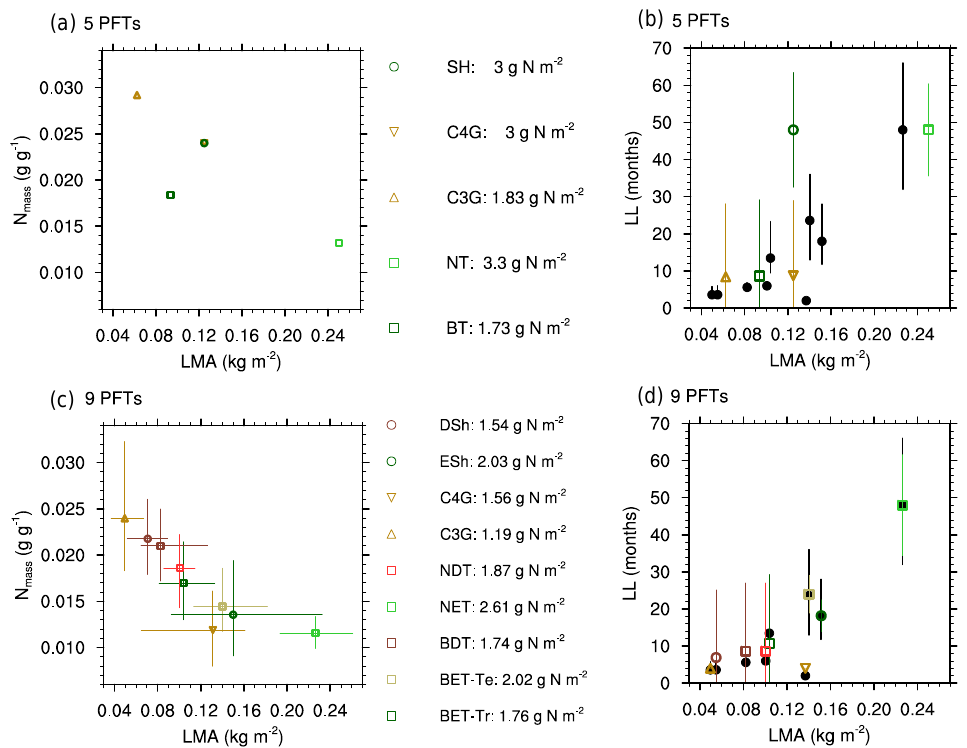
Figure 1. Trade-offs between leaf mass per unit area (LMA; kgm − 2 ) and (a, c) leaf nitrogen (gg − 1 ) , and between LMA and (b, d) leaf life span (LL). (a, b) Parameters in the standard JULES, converted from N l0 and σ l based on 0.4kgC per kg dry mass (assumed parameter in JULES from Clark et al., 2011). (c, d) Median values from the TRY database for the new nine PFTs. In (b) and (d) , the filled circles show the observed data and the open shapes show the median values from global simulations of JULES from 1982 to 2012. Vertical and horizontal lines show the range of vales between the lower and upper quartile of